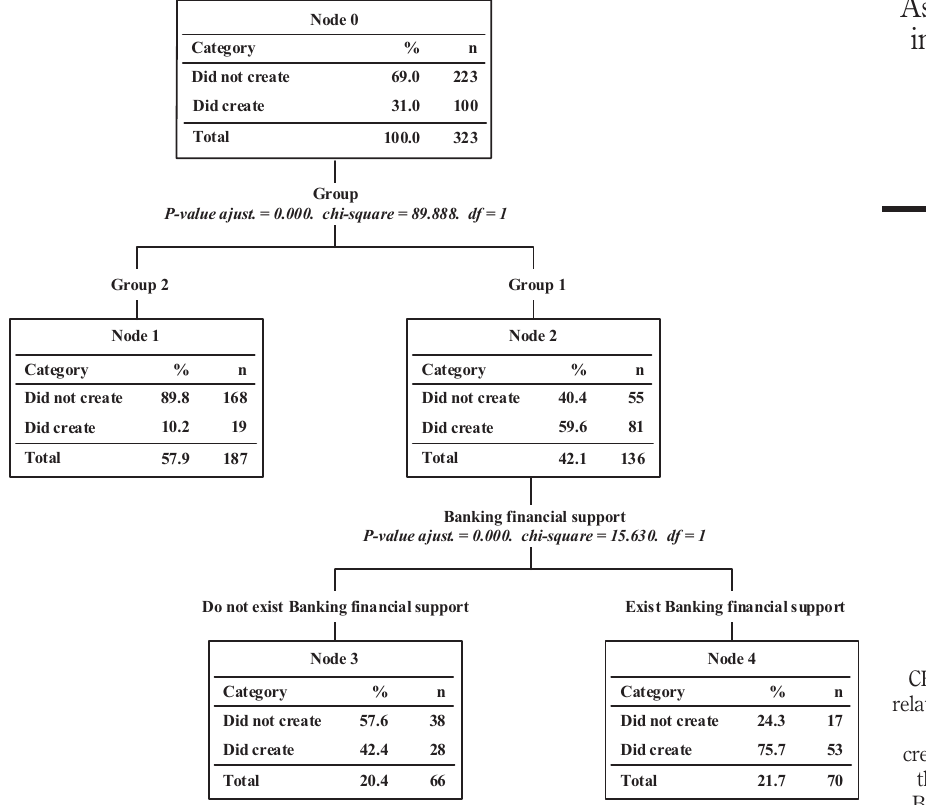
Figure 4. CHAID diagram of relationship between the Organization created/not created, the Group and the Banking Financial